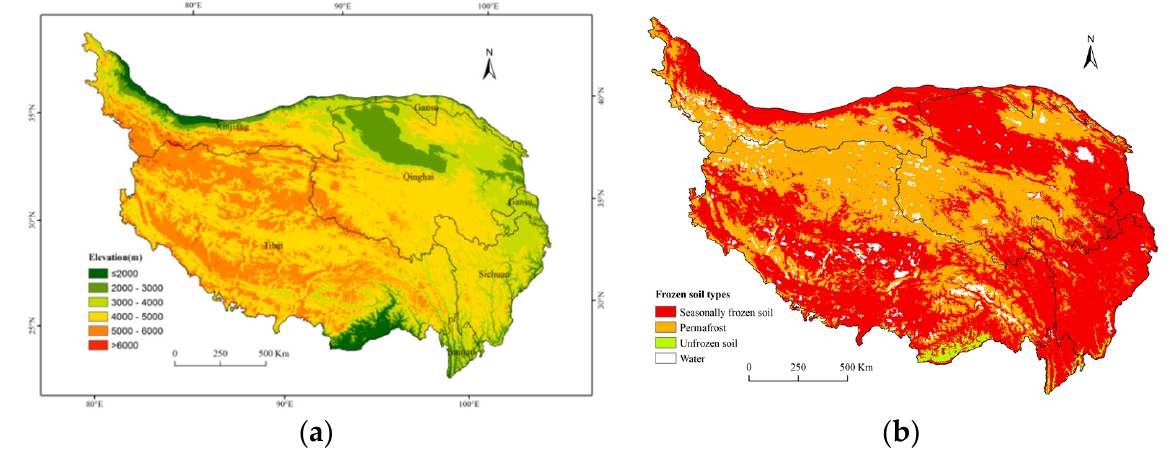
Figure 1. Elevation ( a ) and spatial distribution of frozen soil ( b ) on the Qinghai-Tibet.